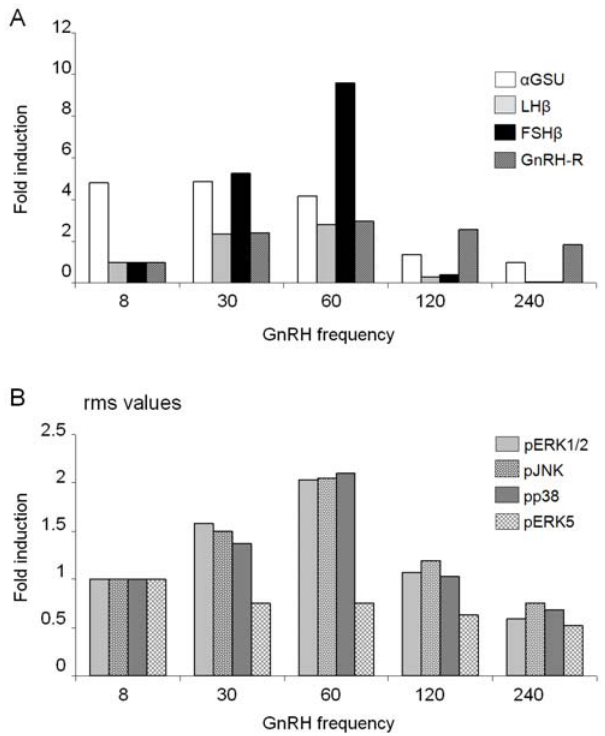
Figure 5. Differential GnRH-R concentration alone does not give rise to full differential gonadotropin subunit gene expression. The receptor-enhanced model was simulated for 1440 min with the total receptor concentration kept constant. For each pulse-frequency, the initial concentration of the free receptor, R, was changed to a factor multiplied by the basal value of 0.01 nM, in accordance with the fold stimulation of GnRH-R promoter activity as reported in the literature [13]. (A) Fold differences for the expression of each subunit, as well as for GnRH-R, were then calculated and plotted as in Figure 1B. (B) Fold differences of the rms value of each activated MAPK were computed and plotted.